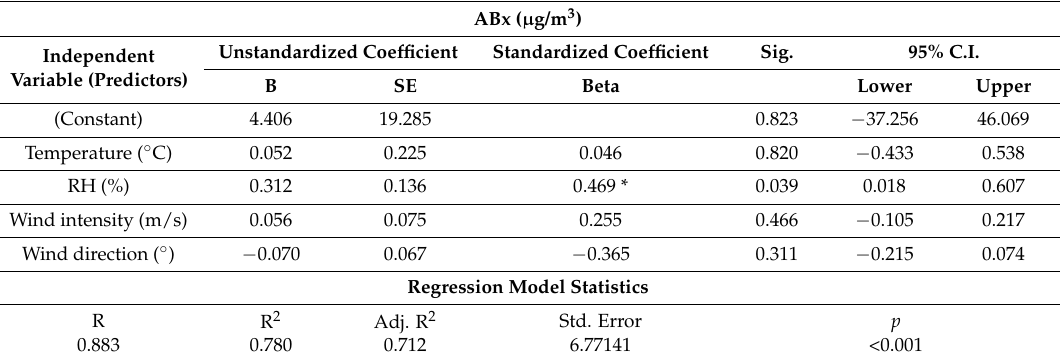
Table 13. Summary of the multiple regression model results. Both unstandardized (B) and standardized (Beta) coefficients and the standard error (SE) for each independent variable, the model statistical significance (Sig.), and the upper and lower 95% confidence intervals (95% C.I.) for beta are reported. Other parameters are reported as indicators of the regression model: R, R 2 , adjusted R 2 (Adj. R 2 ), standard error (Std. Error), and p value ( p ). * Variable is significant at the 0.05 level (2-tailed). ABx ( µ g/m 3